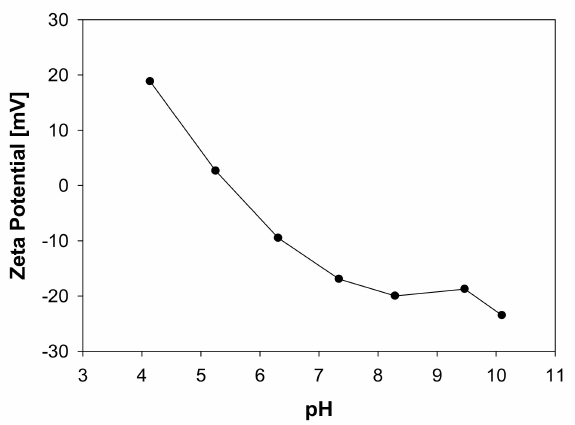
Figure 8. Impact of pH on zeta potential of Hematite particles (-325# mesh) in distilled water (0.01 M